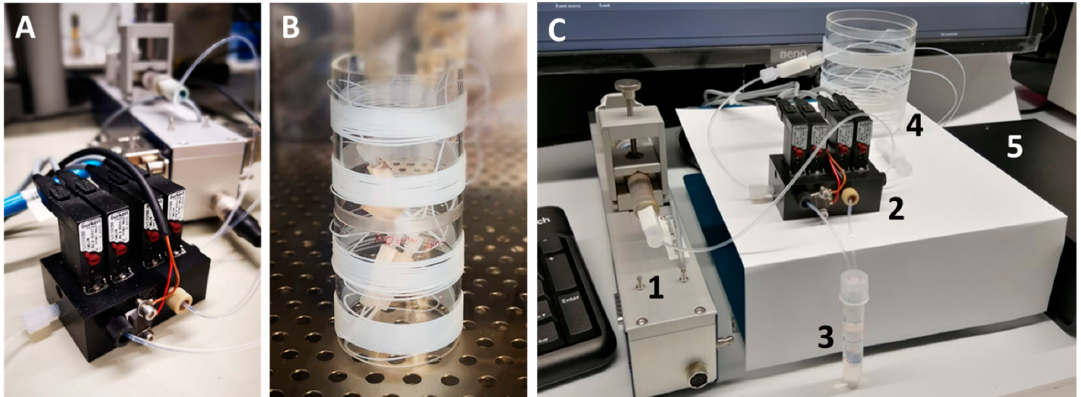
Figure 5. ( A ) Picture of the valve module required for dynamic cultivation using a single syringe pump; ( B ) storage module for droplet sequences located inside an incubator; ( C ) complete setup, including (1) syringe pump, (2) valve module, (3) void volume container, (4) storage coil and (5) photo-fluorometric sensor. Table 1. Cell numbers per droplet in dependence on appropriate inoculum densities. Inoculum Compartmentalized in Droplets of